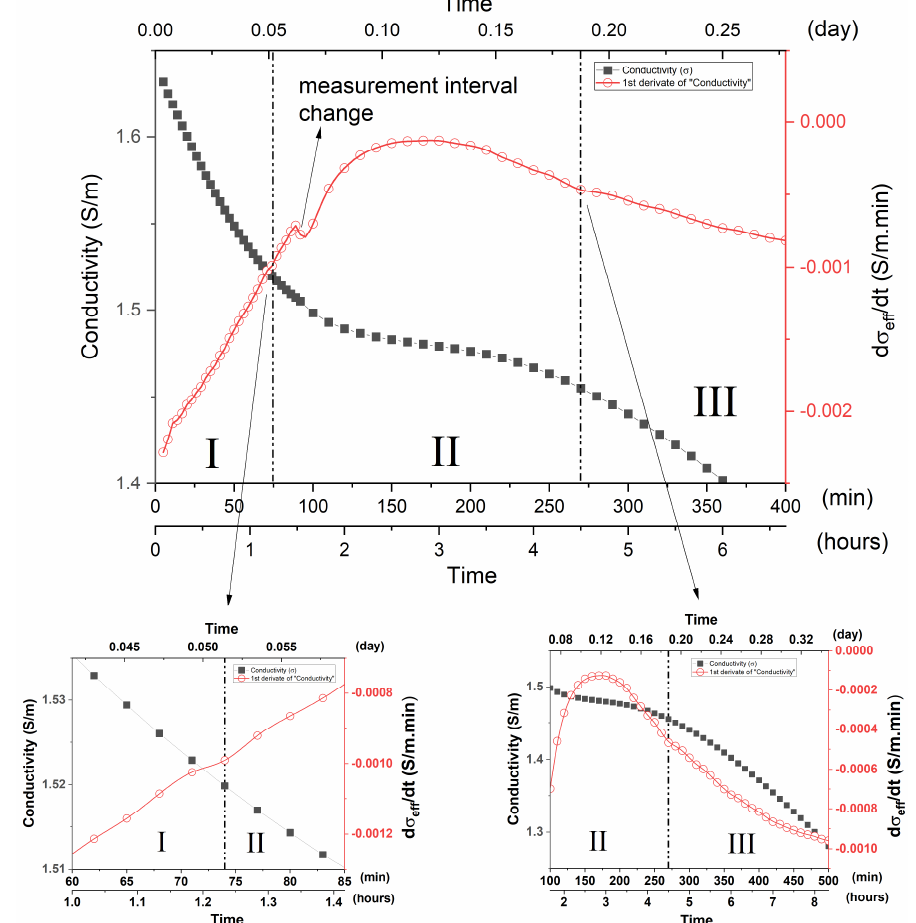
Figure 7. Effective electrical conductivity, σ eff , and its derivative, d σ eff /dt, as a function of the geopolymerization time, highlighting regions I and III: MK1 system. Insets illustrate the inflection points of the dσ eff /dt curve adopted as a delimiter between the referred stages.